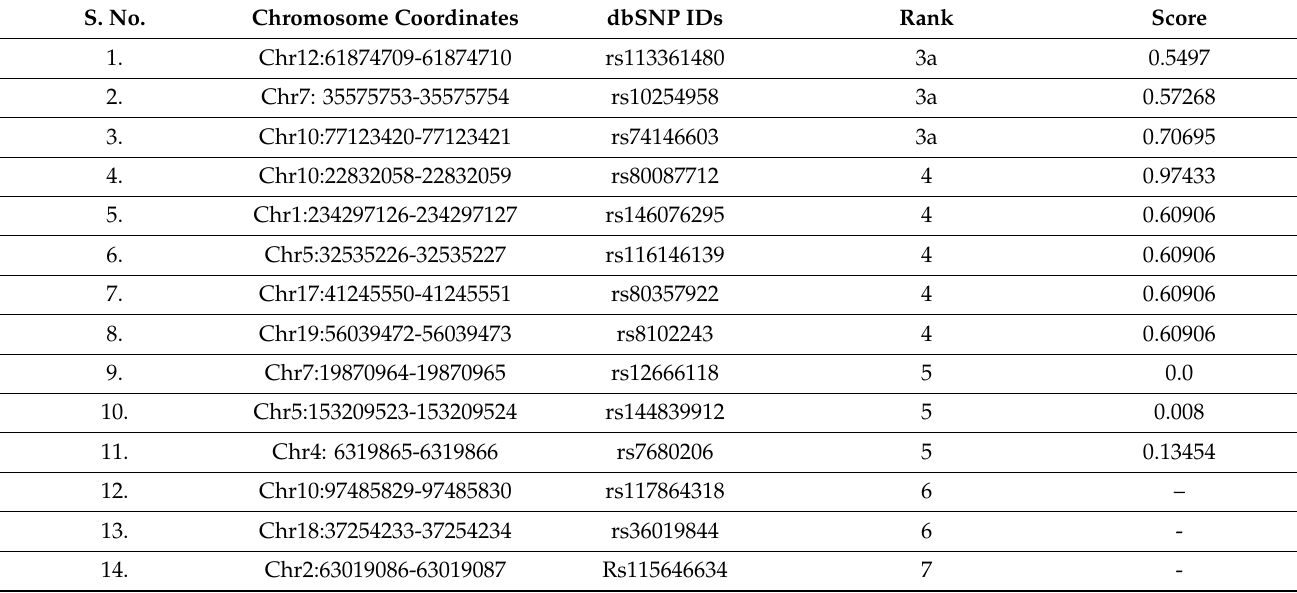
Table 2. RegulomeDB score for the SNPs that showed significance in the GWAS analysis.